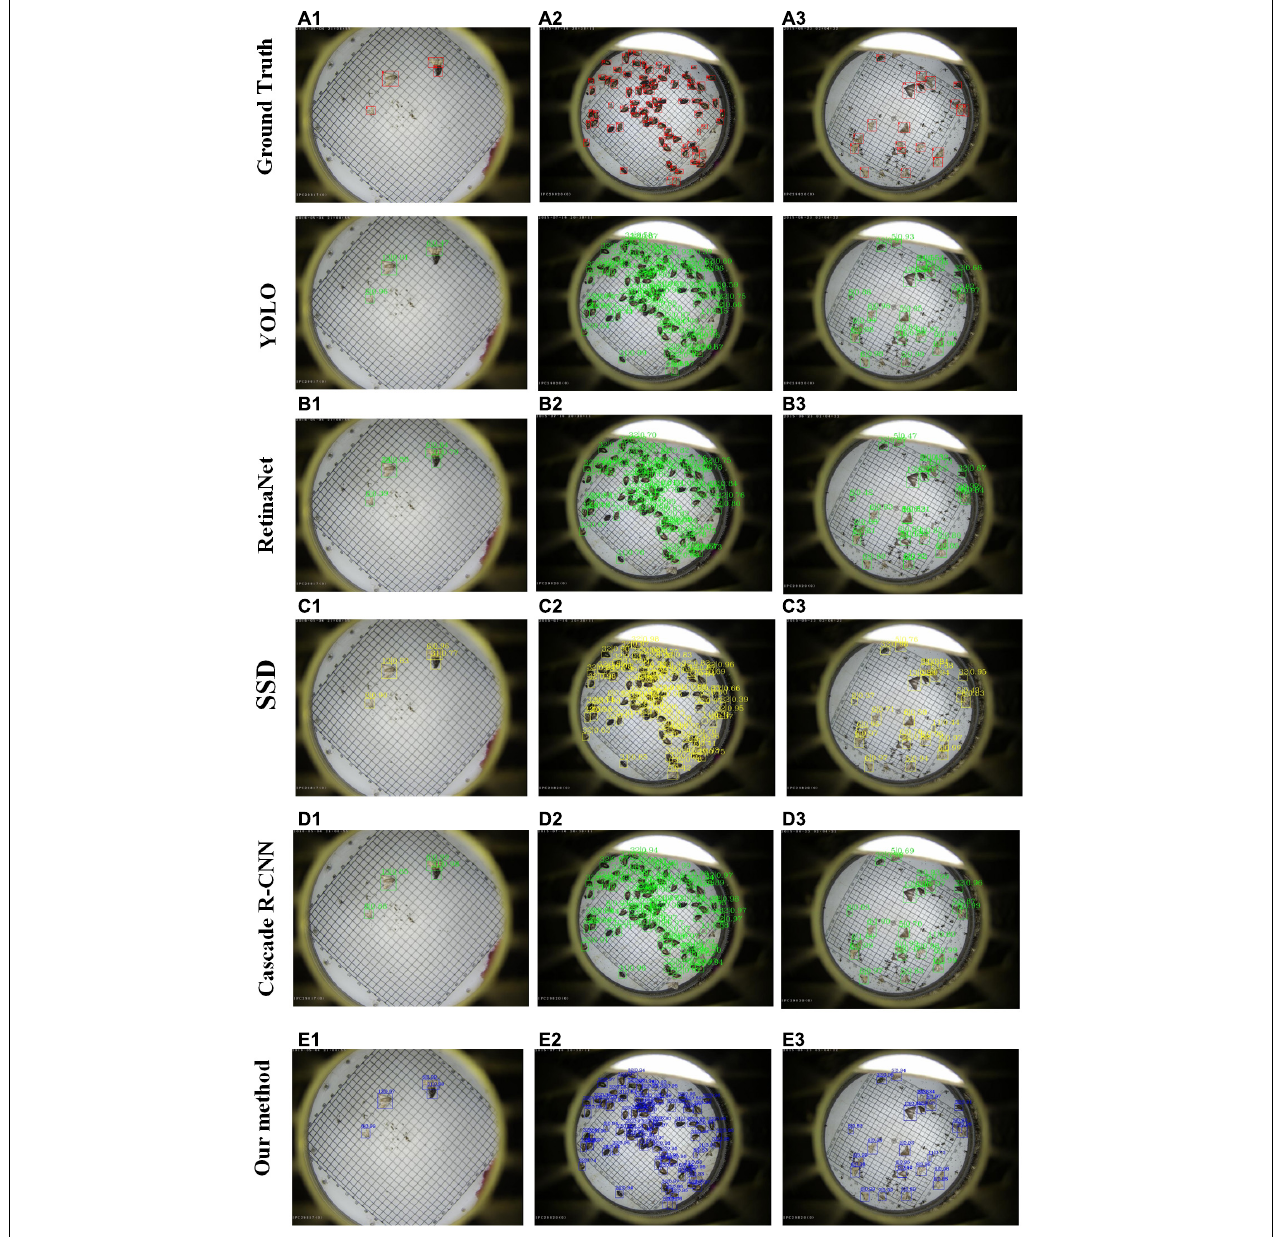
FIGURE 7 | Selected examples of agricultural pest detection results by using YOLO, RetinaNet, SSD, Cascade R-CNN, and our method.